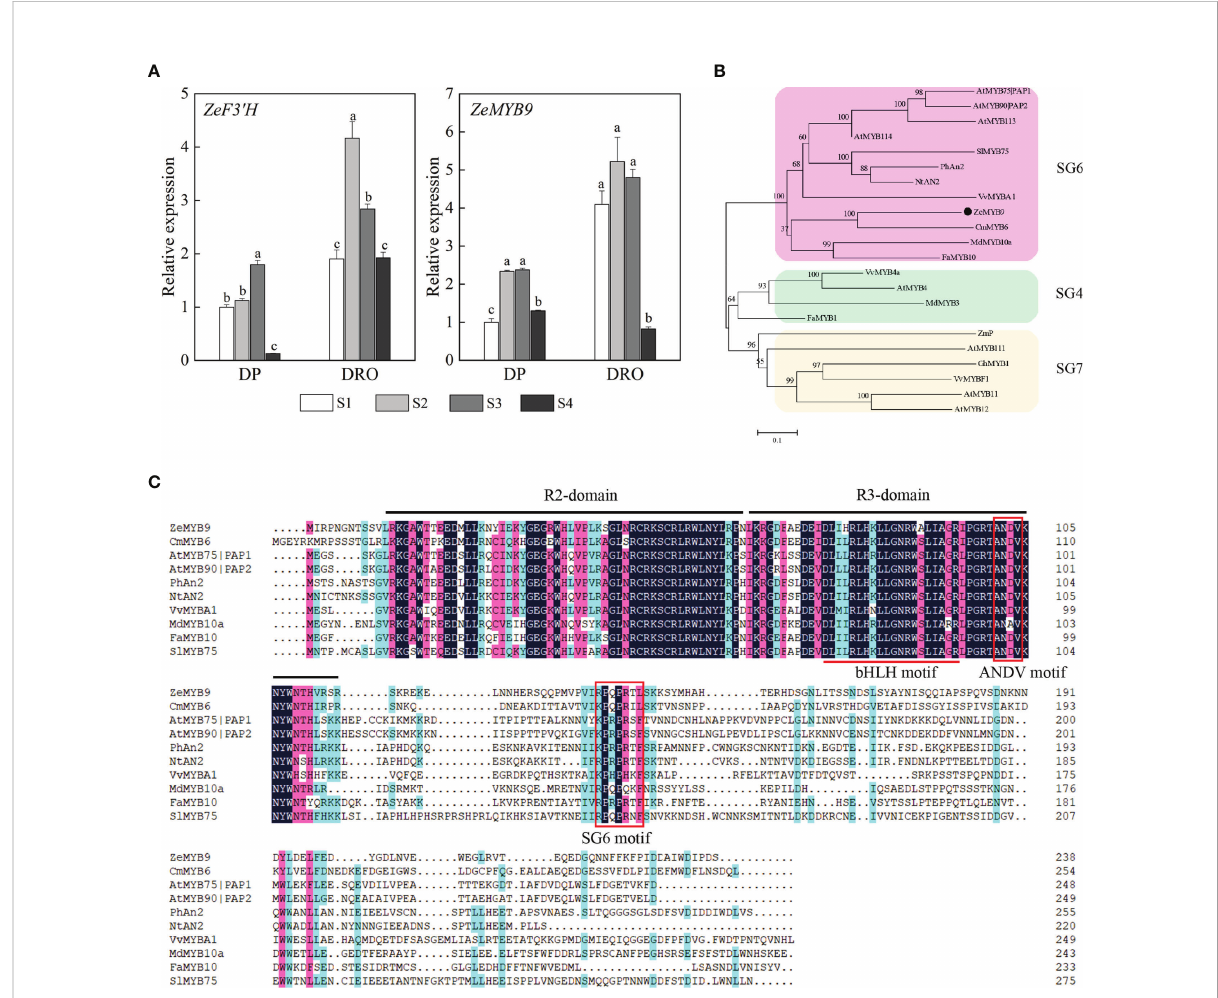
FIGURE 2 Expression analysis of ZeF3 ’ H and ZeMYB9 and sequence analysis of ZeMYB9. (A) Relative expression levels of ZeF3 ’ H and ZeMYB9 in the petals of DP and DRO at different developmental stages. ZeACT gene was used as an internal control for normalization, and three biological replicates were performed. Error bars indicated standard error (SE). And different lowercases indicate signi fi cant differences ( P < 0.05). (B) Phylogenetic tree of different R2R3-MYB proteins participating in anthocyanin biosynthesis in other plants. (C) Multiple alignment of the amino acid sequences of SG6 R2R3-MYB proteins from different plants. The black line at the top indicated the conserved R2-domain and R3-domain. The red underline indicated a motif ([D/E]Lx 2 [R/K]x 3 Lx 6 Lx 3 R) interacting with a bHLH transcription factor. The red box indicated the conserved ANDV motif and SG6 motif. The GenBank accession numbers of MYB proteins from other species were as follows: the SG6 MYBs as Arabidopsis thaliana AtMYB75|PAP1 (AT1G56650.1), A. thaliana AtMYB90|PAP2 (AT1G66390.1), A. thaliana AtMYB113 (AT1G66370.1), A. thaliana AtMYB114 (AT1G66380.1), Solanum lycopersicum SlMYB75 (NP_001265992.1), Petunia hybrida PhAn2 (AAF66727.1), Nicotiana tabacum NtAN2 (ACO52470.1), Vitis vinifera VvMYBA1 (BAD18977.1), Chrysanthemum morifolium CmMYB6 (KR002097.1), Malus domestica